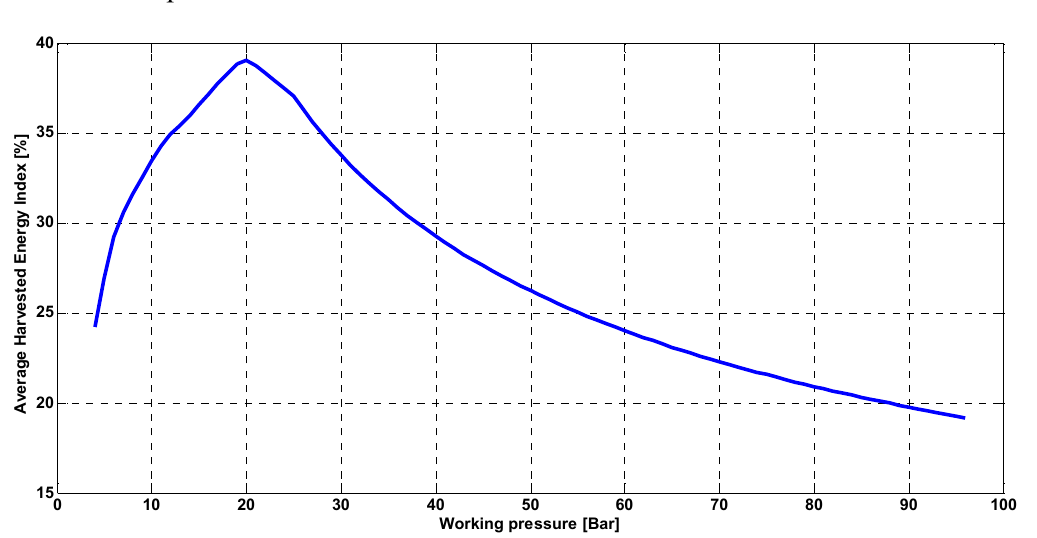
Figure 10. Change in average HEI in a day time scale considering only constant working pressure for